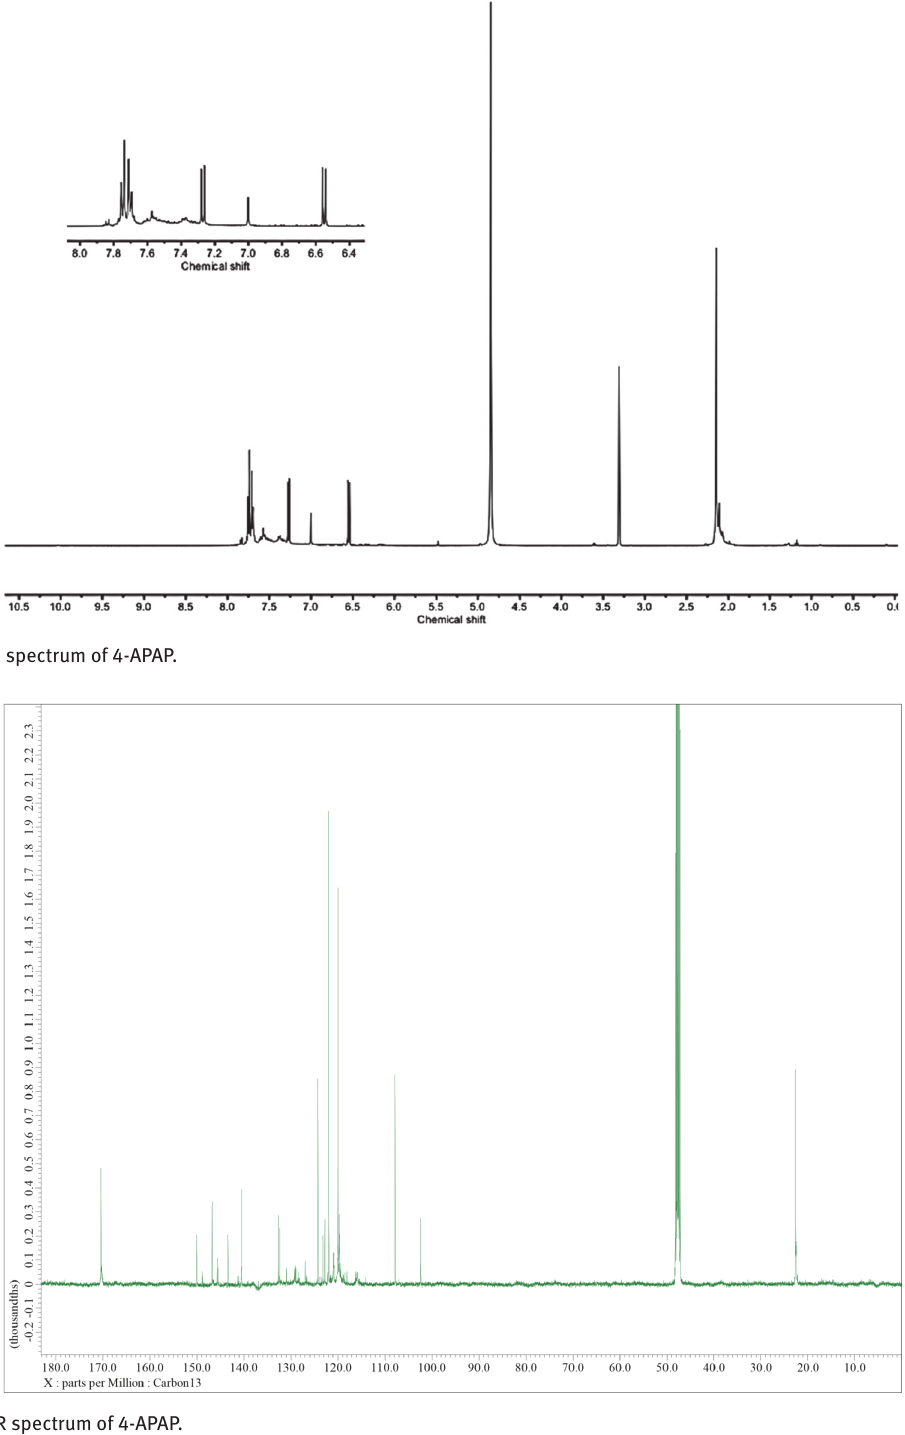
Figure 6: 13 C-NMR spectrum of